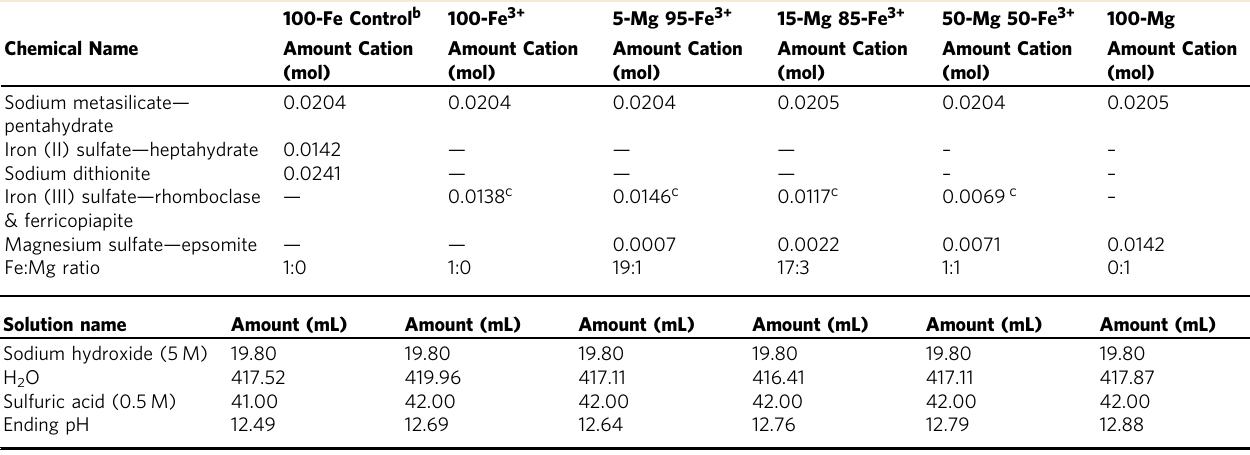
Table 1 Chemistry used in selected synthesis experiments a